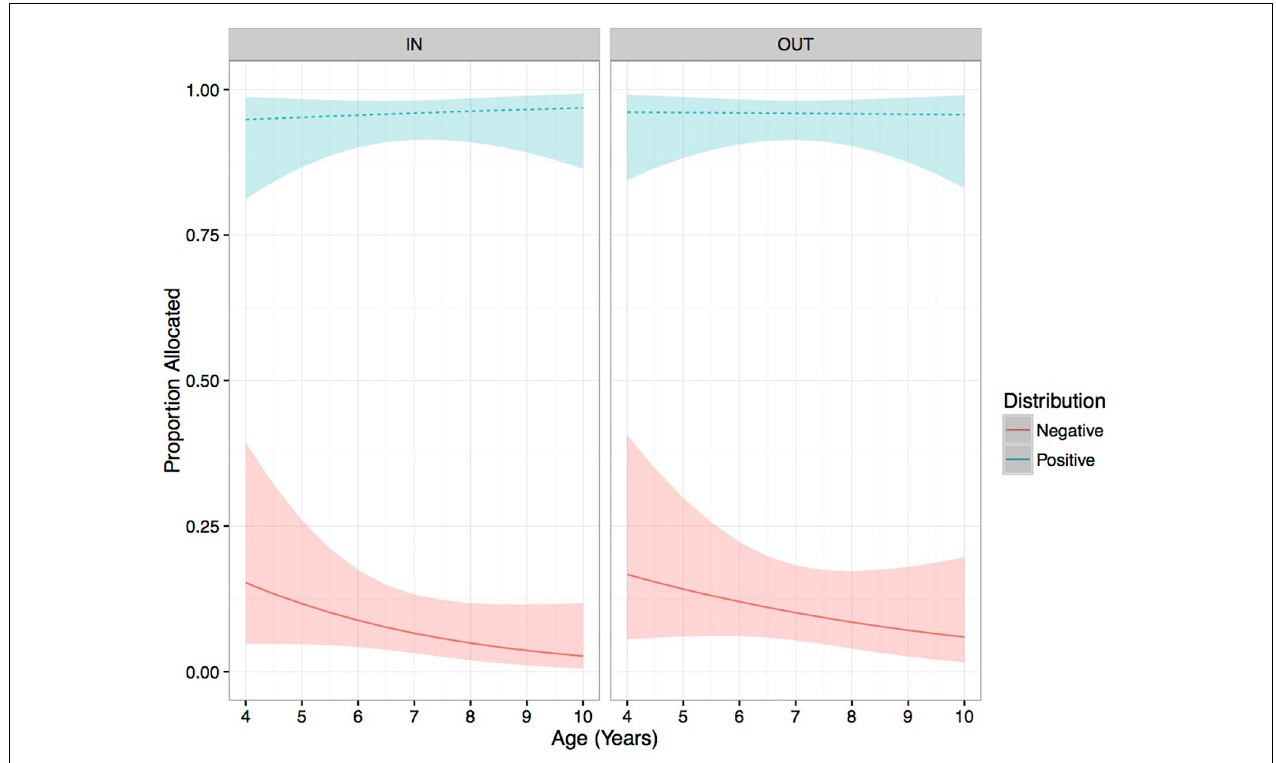
FIGURE 3 | Predicted proportion allocated for females on Care trials, Distribution, facetted by Group, plotted over age. Ribbons show 95% confidence intervals.